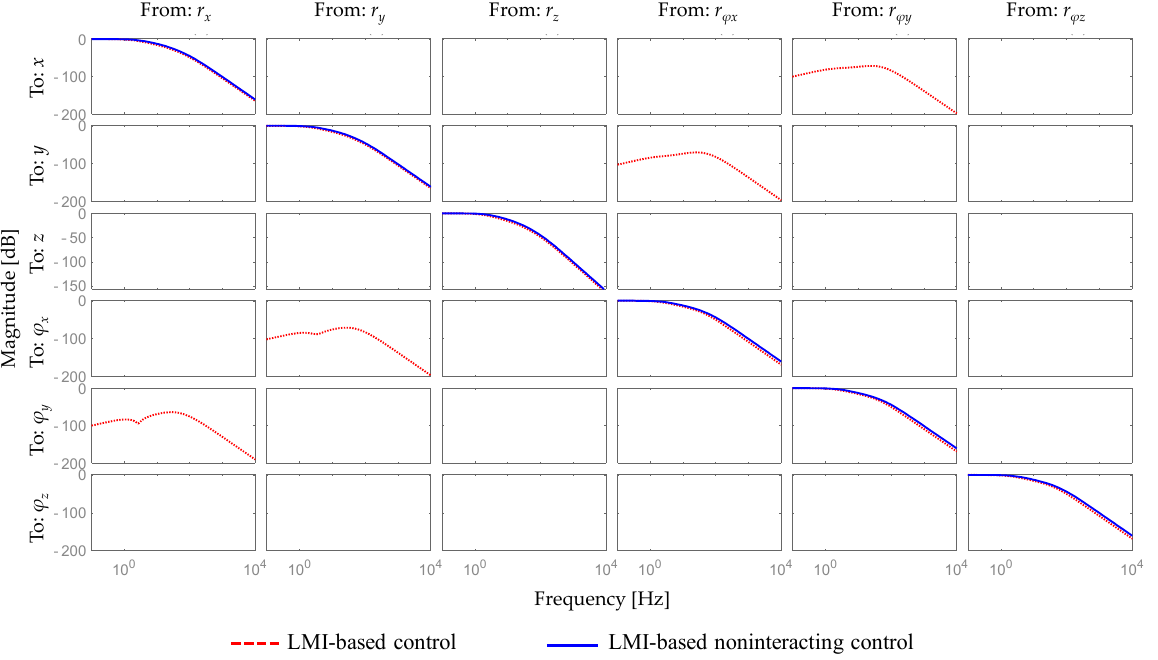
Figure 5. Frequency response of the platform positioning performance.